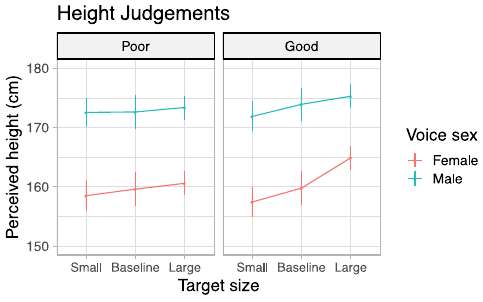
Figure 7. Modulation of perceived height. Poor vocal modulators (left) had little to no influence on their perceived height, whereas good vocal modulators (right) were reliably perceived as being shorter or taller. This was particularly evident among female good vocal